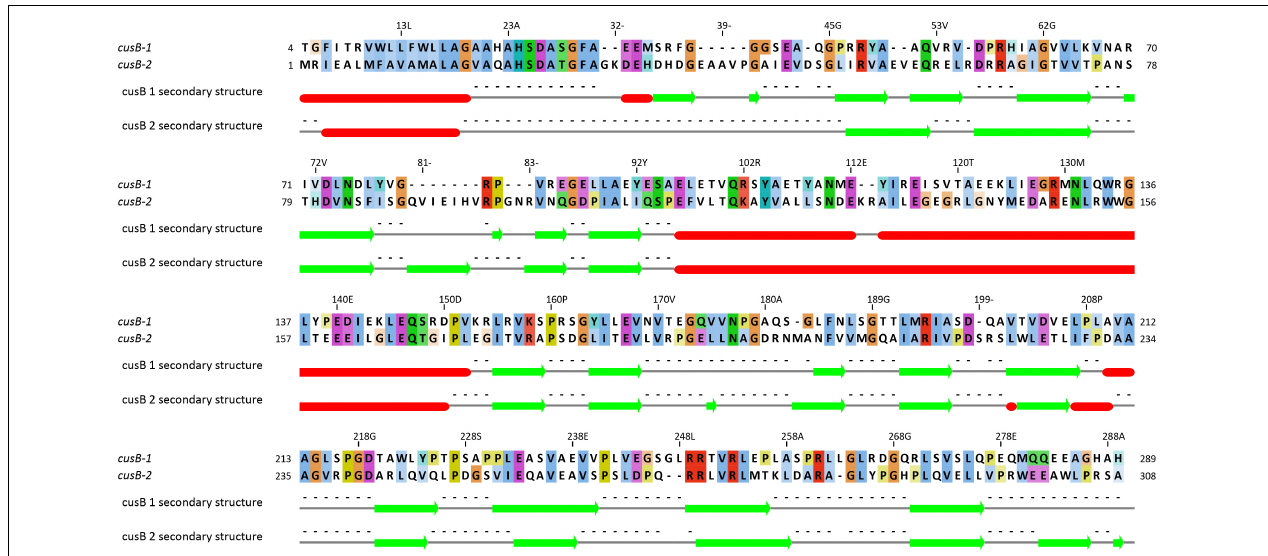
FIGURE 6 | Pairwise alignment of CusB-1 and CusB-2 protein sequences from Thiohalobacter thiocyanaticus perfomed by Needleman-Wunch algorithm (sequences identity 28%, similarity 43%, and alignment score 186). Secondary structure of each protein was modeled by Jpred 4. Beta-strands and alpha helices are shown by green arrows and red cylinders,